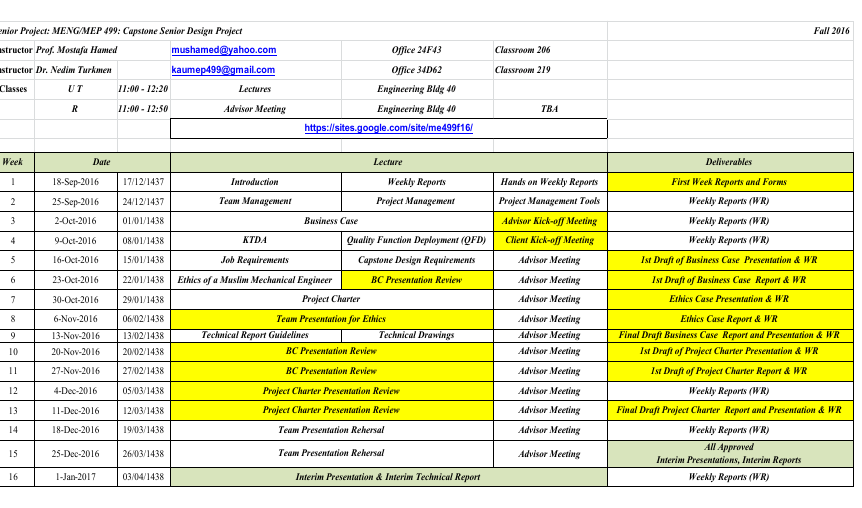
Table 1. Time Table for the Weekly coordinator